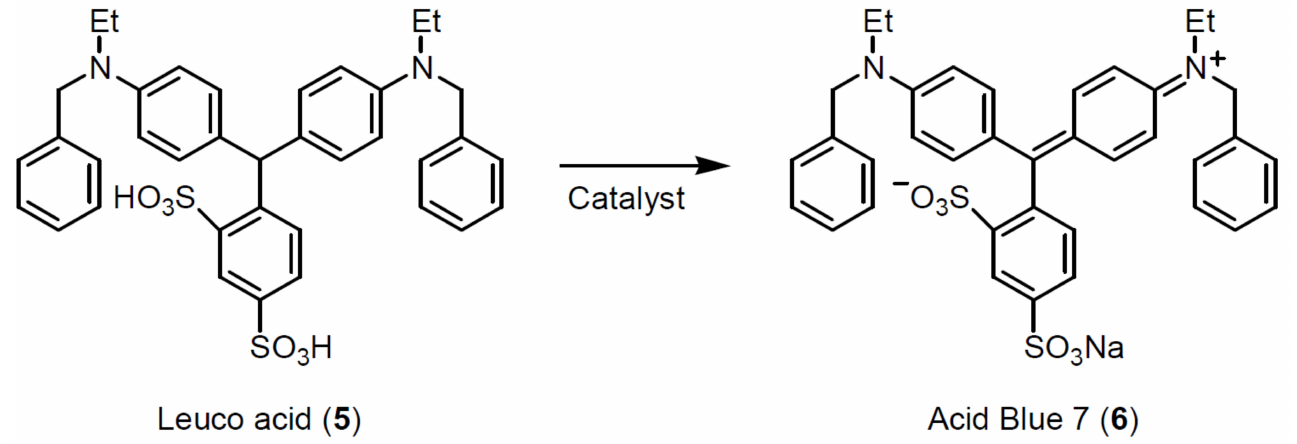
Scheme 2. Schematic representation for Acid Blue 7